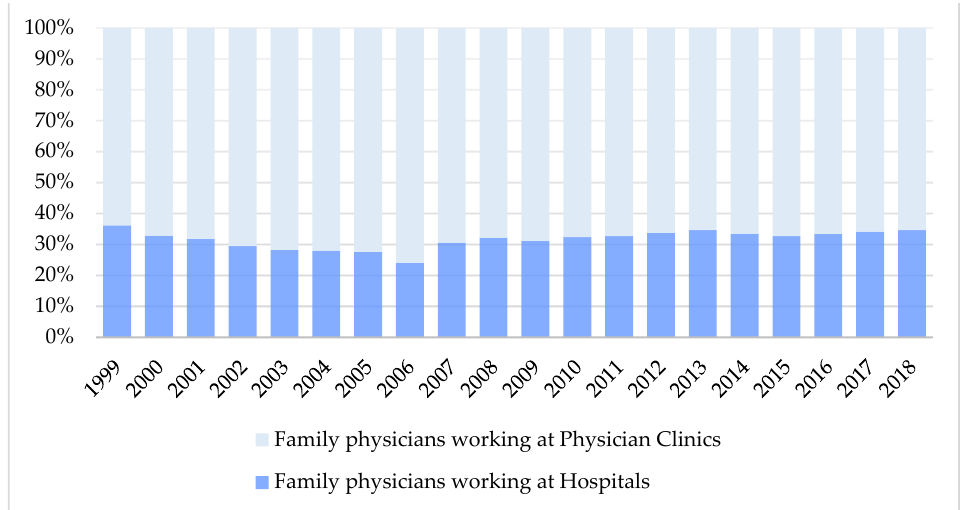
Figure 5. Changes in the numbers of residents in family physician training and number of family physicians in various practice settings in Taiwan from 2002 to 2018. *1999–2001 data of the number of residents in family medicine training are not available.